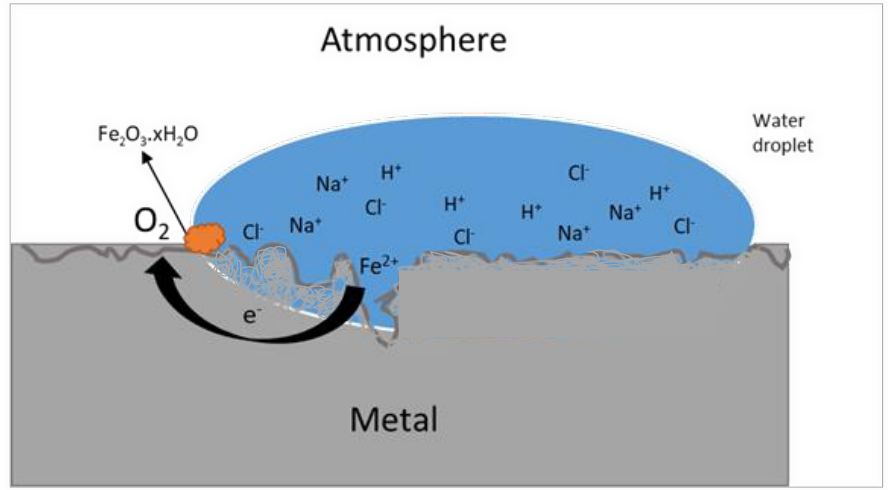
Figure 1 . A depiction of the reaction between a coated steel substrate with a water droplet from the atmosphere.